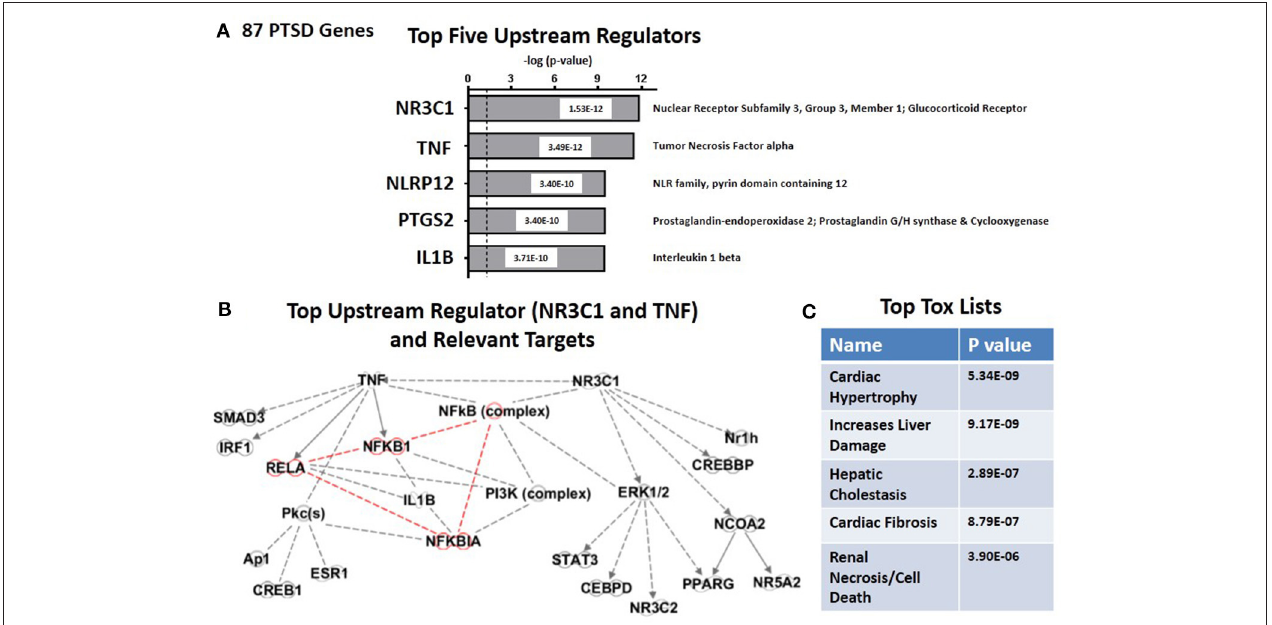
FIGURE 2 | Upstream regulation of risk genes for PTSD. (A) Predicted Top Five Upstream Regulators. The top two are NR3C1 (Glucocorticoid Receptor) and TNF α . (B) Predicted Targets of top two upstream regulator, NR3C1 (Glucocorticoid Receptor) and TNF α . (C) Predicted Top Tox (icology) Functions. Top tox function is cardiac